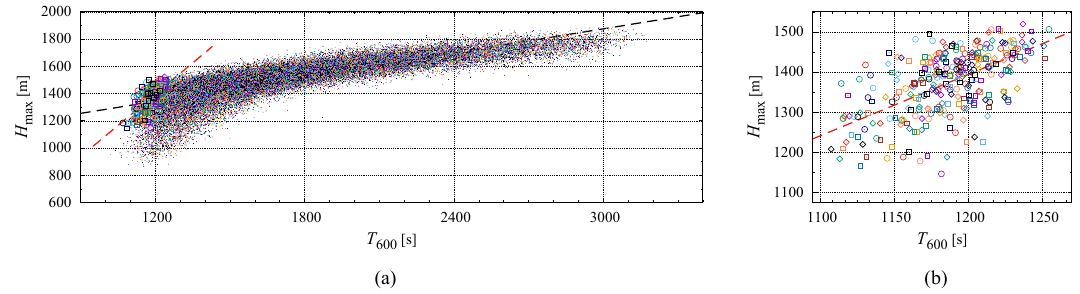
Figure 9. Attained maximum height against the time when the raindrop passes the height of 600m (nearly cloud bottom), T 600 . The black and red dashed lines show the least-squares regression line for all the surface raindrops and for the first 10 raindrops, respectively. In (b) only the plots for the first 10 raindrops are